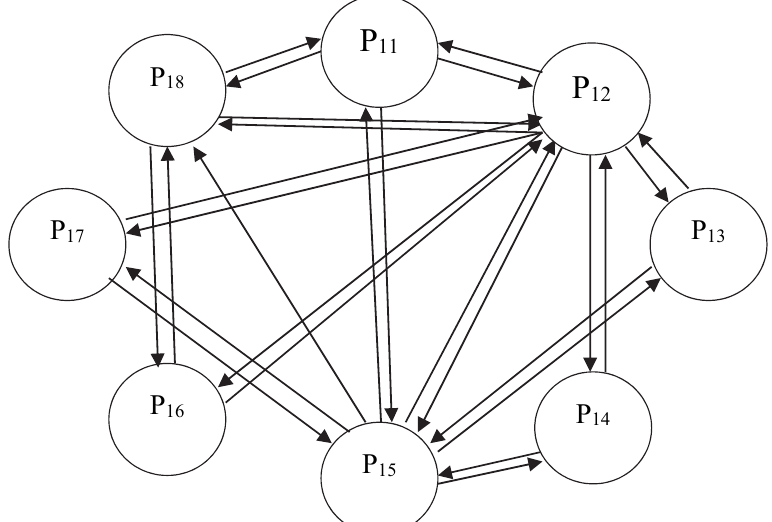
Fig. 3. Digraph for Cost quality of treatment and